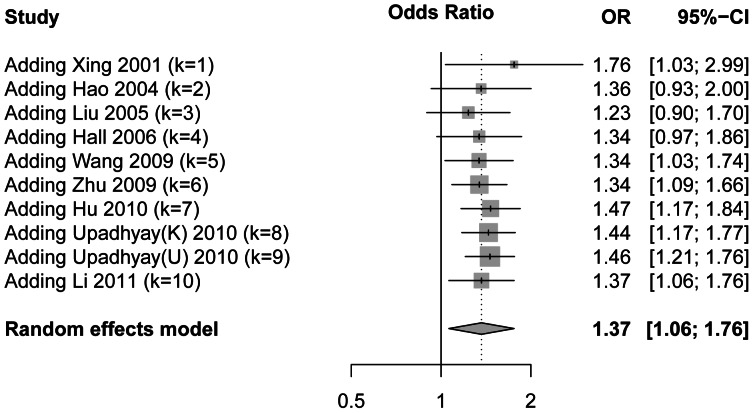
Forest plots of results of cumulative meta-analysis by published year in the recessive model.Pooled odds ratios (ORs) with 95% confidence limits (CIs) at the end of each information step were shown.